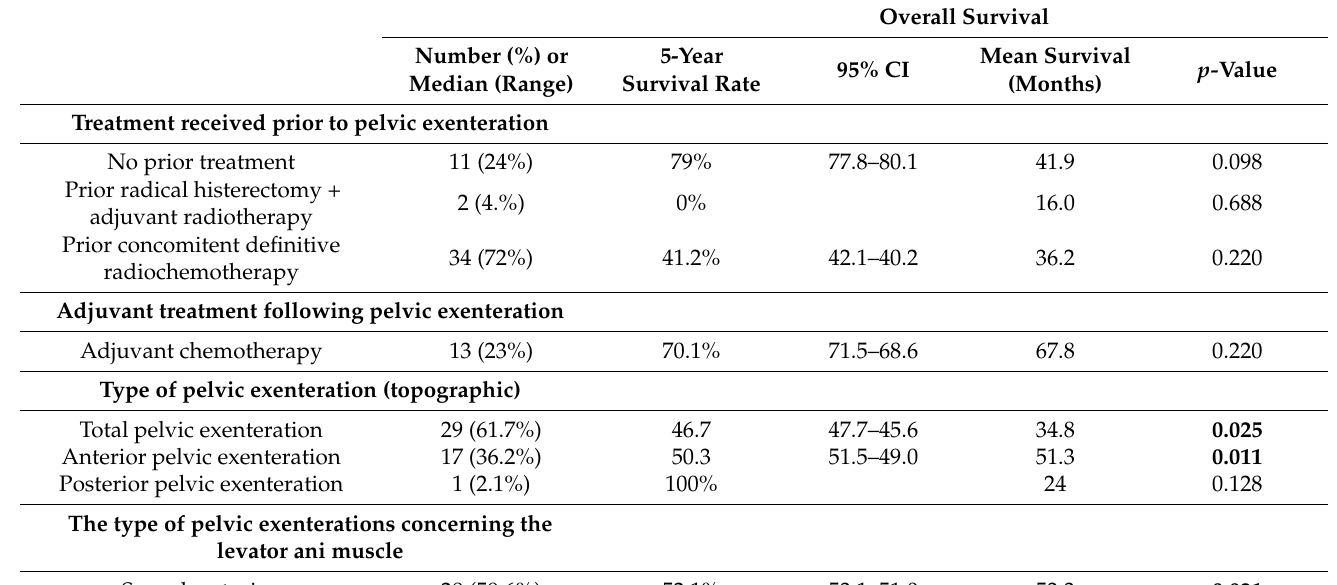
Table 2. Treatments, complications, and the current status of the 47 patients included in the